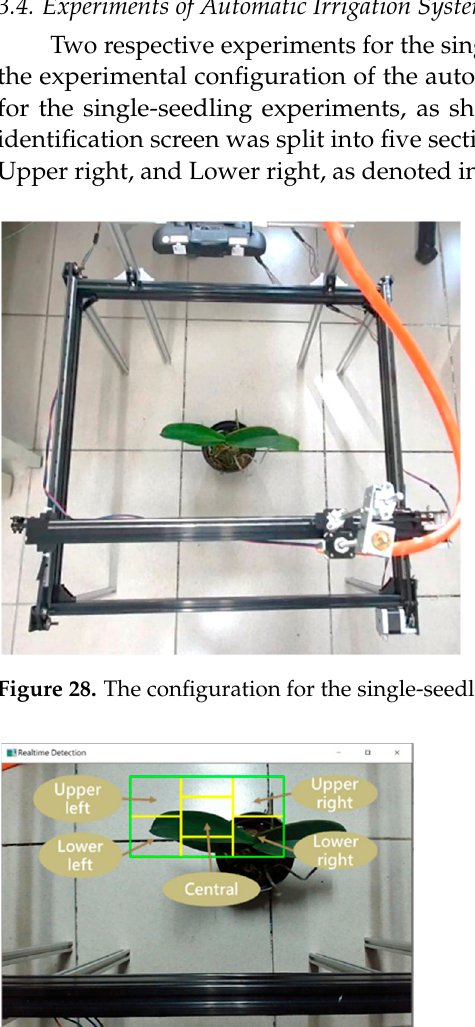
Figure 27. Relationship of duty time for valve opening (4 to 11 s) and watering amount.